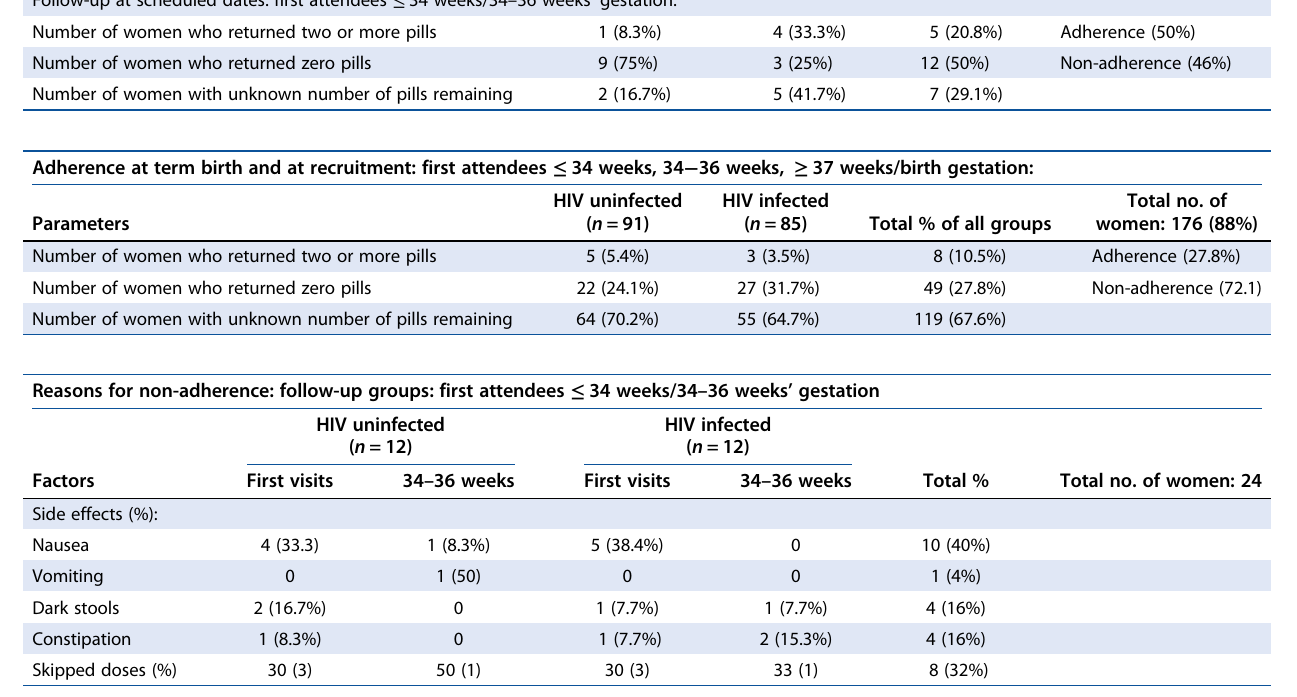
Table 4: Pill count and self-reported adherence